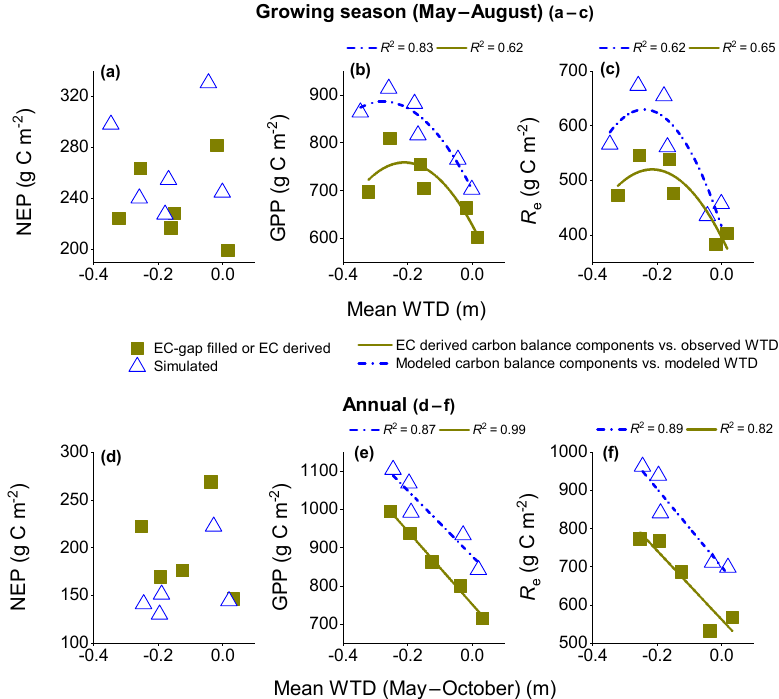
Figure 8. Regressions ( P < 0 . 001) of growing season (May–August) sums of modeled and EC-derived (Flanagan and Syed, 2011) (a) NEP, (b) GPP and (c) R e on growing season averages of modeled and observed WTD during 2004–2009; regressions ( P < 0 . 001) of annual sums of modeled and EC-derived (Flanagan and Syed, 2011) (d) NEP, (e) GPP and (f) R e on average modeled and measured WTD during ice-free periods (May–October) of 2004–2008 at a western Canadian fen peatland. A negative WTD represents a depth below hollow surface, and a positive WTD represents a depth above hollow surface. A positive NEP means that the ecosystem is a carbon